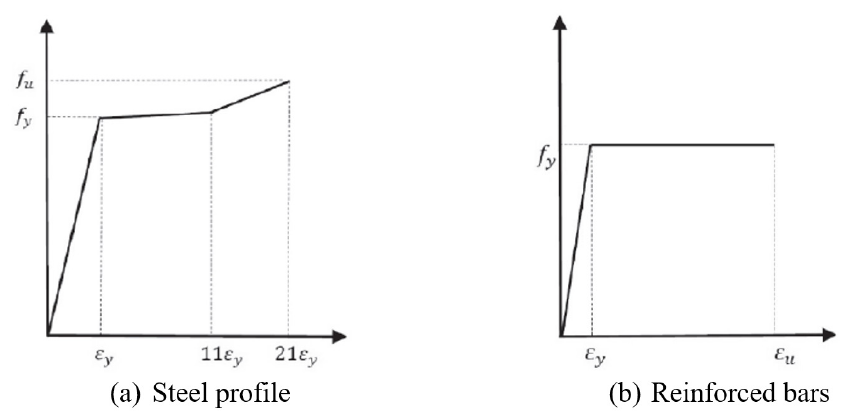
Figure 10. Constitutive models adopted for steel profile and bars.